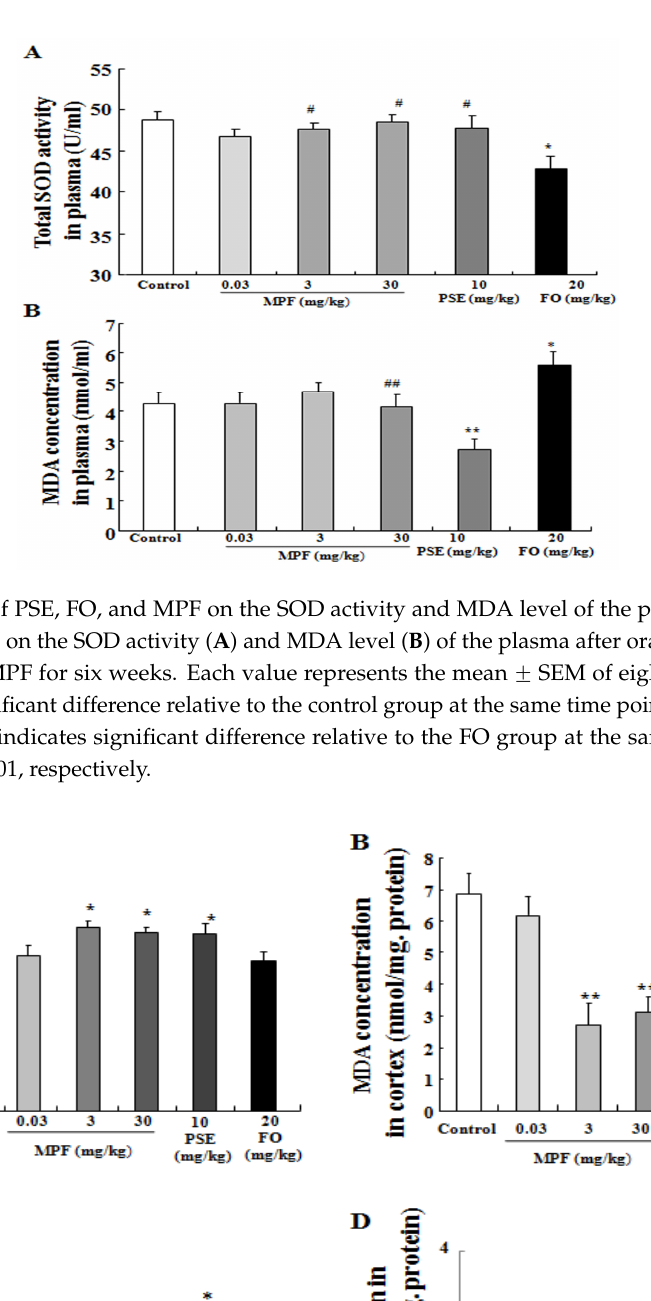
Figure 4. Effects of PSE, FO, and MPF on the SOD activity and MDA level of the plasma. Effects of PSE, FO, and MPF on the SOD activity ( A ) and MDA level ( B ) of the plasma after oral administration of PSE, FO, and MPF for six weeks. Each value represents the mean ± SEM of eight or seven mice. * ,